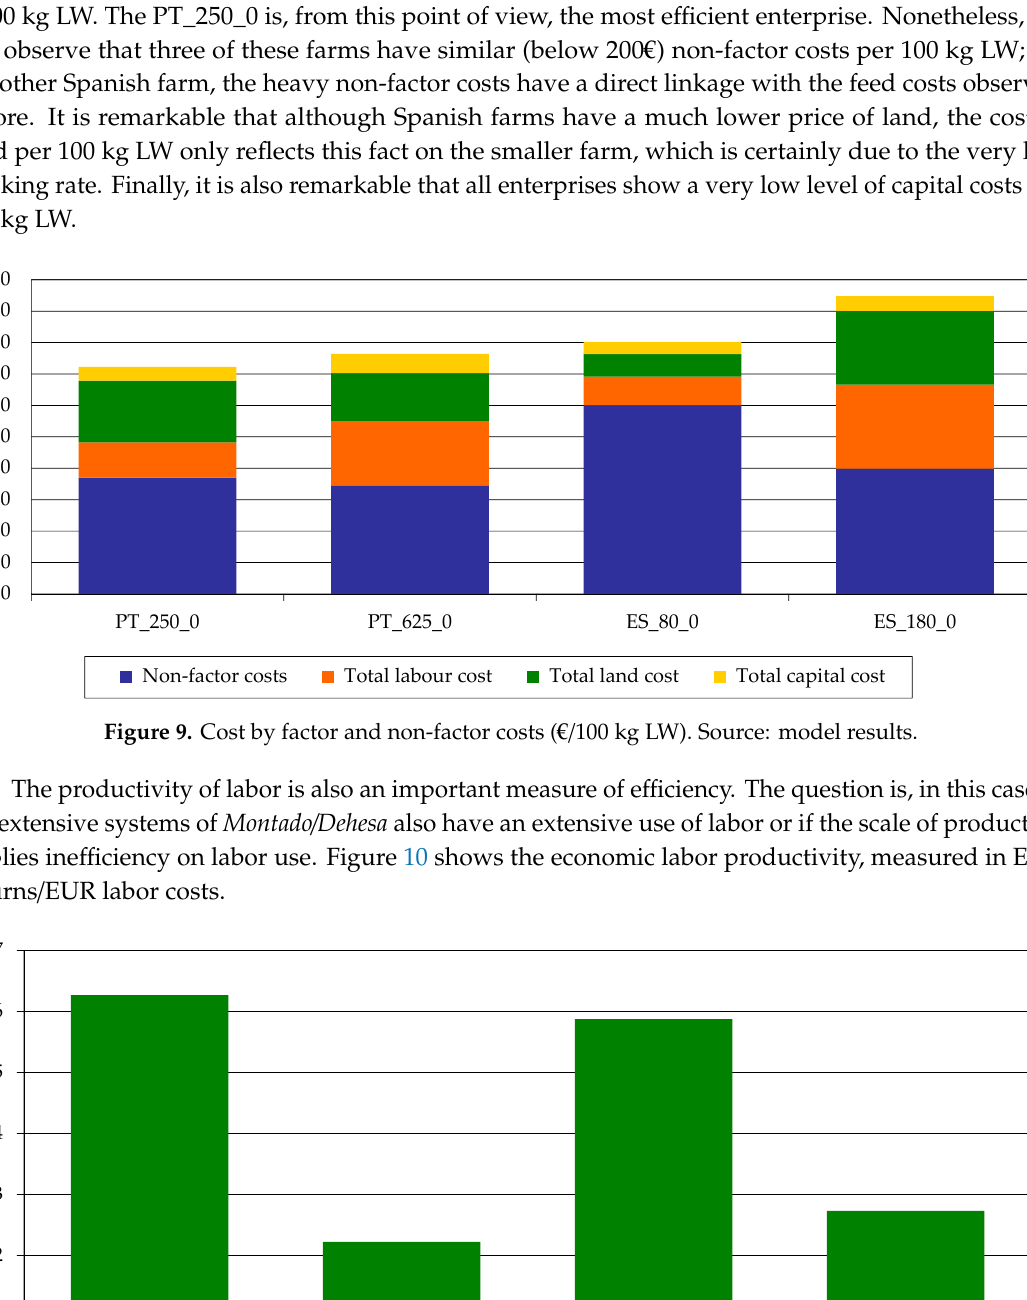
Figure 8. Share of purchased feed. Source: model results.